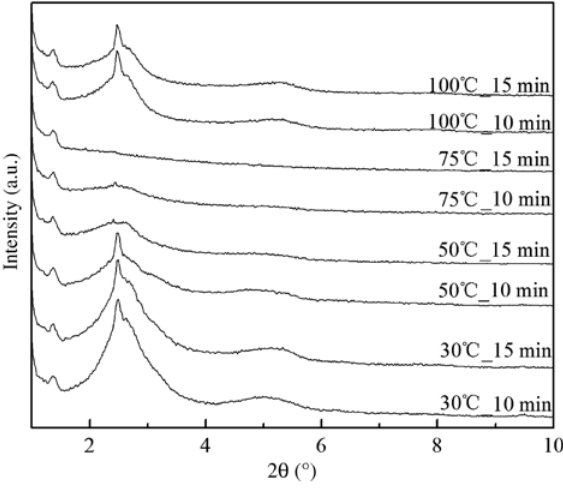
Figure 1 X-ray diffraction patterns of nitrile butadiene rubber/ organophilic montmorillonite composites at different